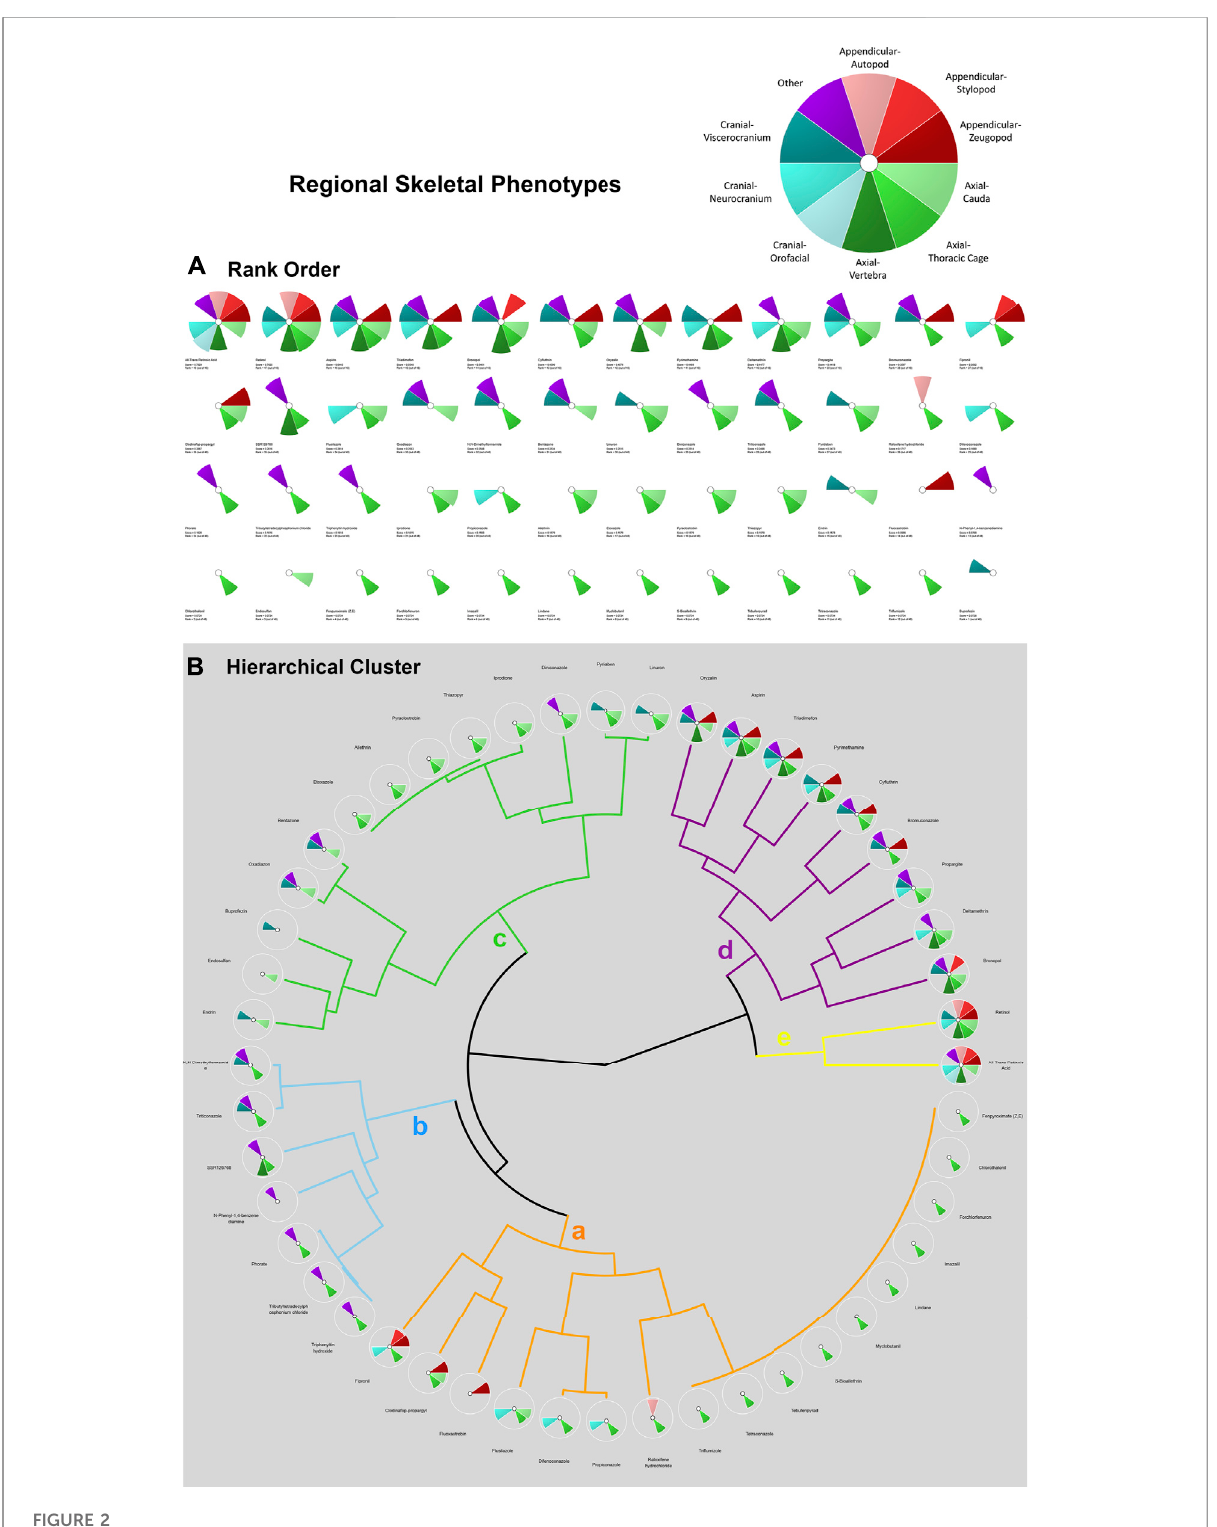
FIGURE 2 ToxPi Rank Order (A) and Hierarchical Clustering (B) results for 48 chemicals associated with adverse skeletal outcomes (ASOs). ASOs include autopod, stylopod, zeugopod, cauda, thoracic cage, vertebra, orofacial, neurocranium, viscerocranium, and other. Most potent chemicals associated with the greatest amount of target disruption have the largest ToxPis and highest ToxPi rank (48). Skeletal defects were categorized into threeskeletalphenotypesandspeci fi edregionsandanunspeci fi edregionasdelineatedintheToxPikey (A)